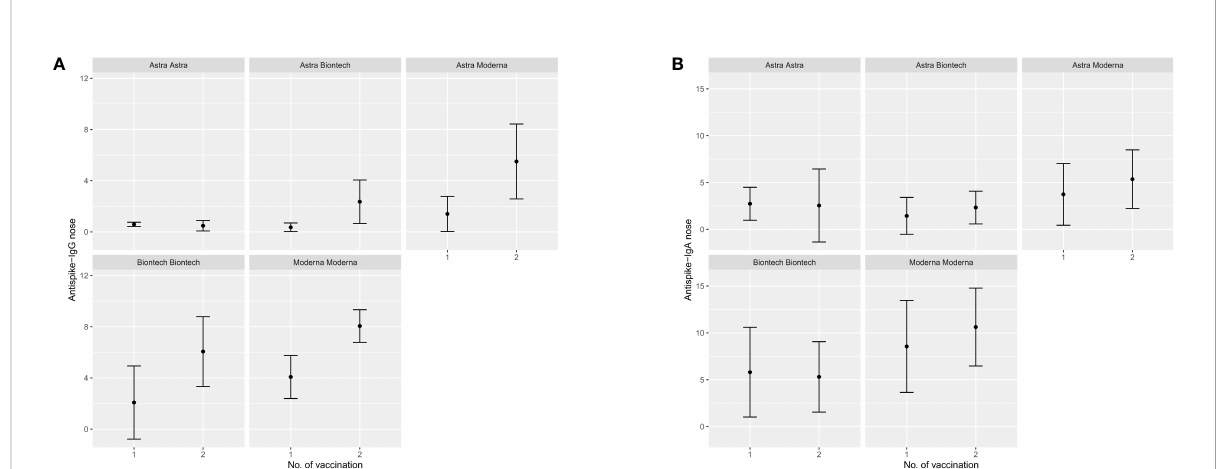
FIGURE 5 Error bar plots depicting the median OD values reached anti-S Abs in nasal swans after fi rst and second vaccination with different vaccination schemes. (A) IgG anti-S Abs in nasal swabs, (B) IgA anti-S Abs in nasal